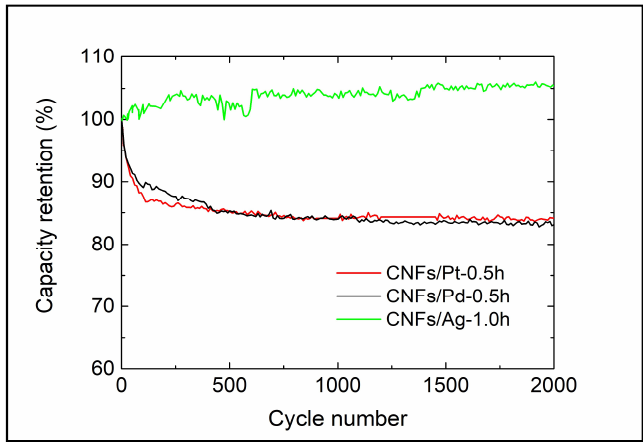
Figure 6. Capacitance retention of CNFs/Pd-0.5h, CNFs/Pt-0.5h and CNFs/Ag-1.0h.